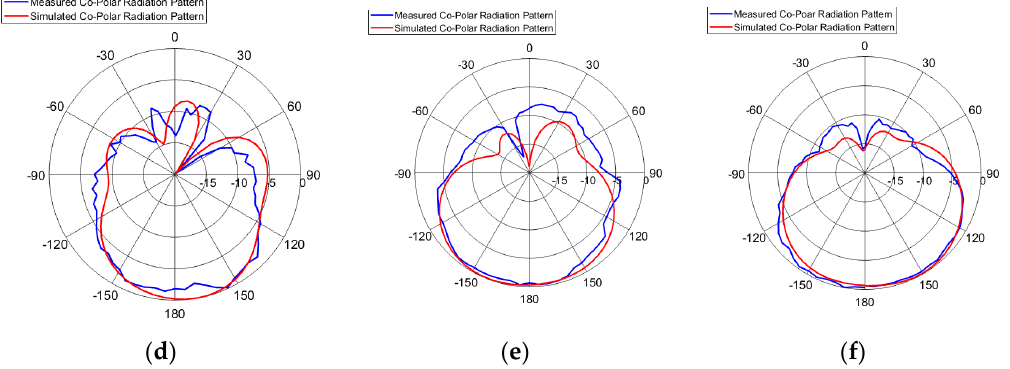
Figure 13. Simulated and measured co-polar ( E θ ) radiation patterns ( θ -cut at ϕ = 0) at 5.5, 6.5, and 7.5 GHz for Port 1 and Port 2, where ( a ), ( b ), and ( c ) are for Port 1 and ( d ), ( e ), and ( f ) are for Port 2.